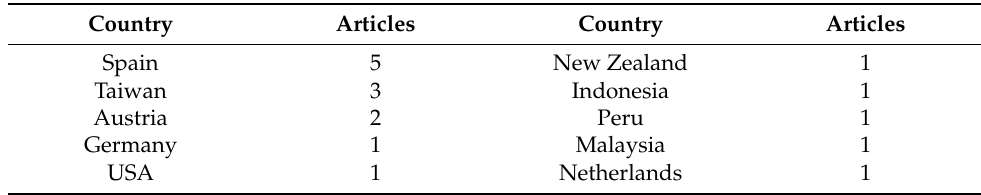
Table 4. Number of articles published per